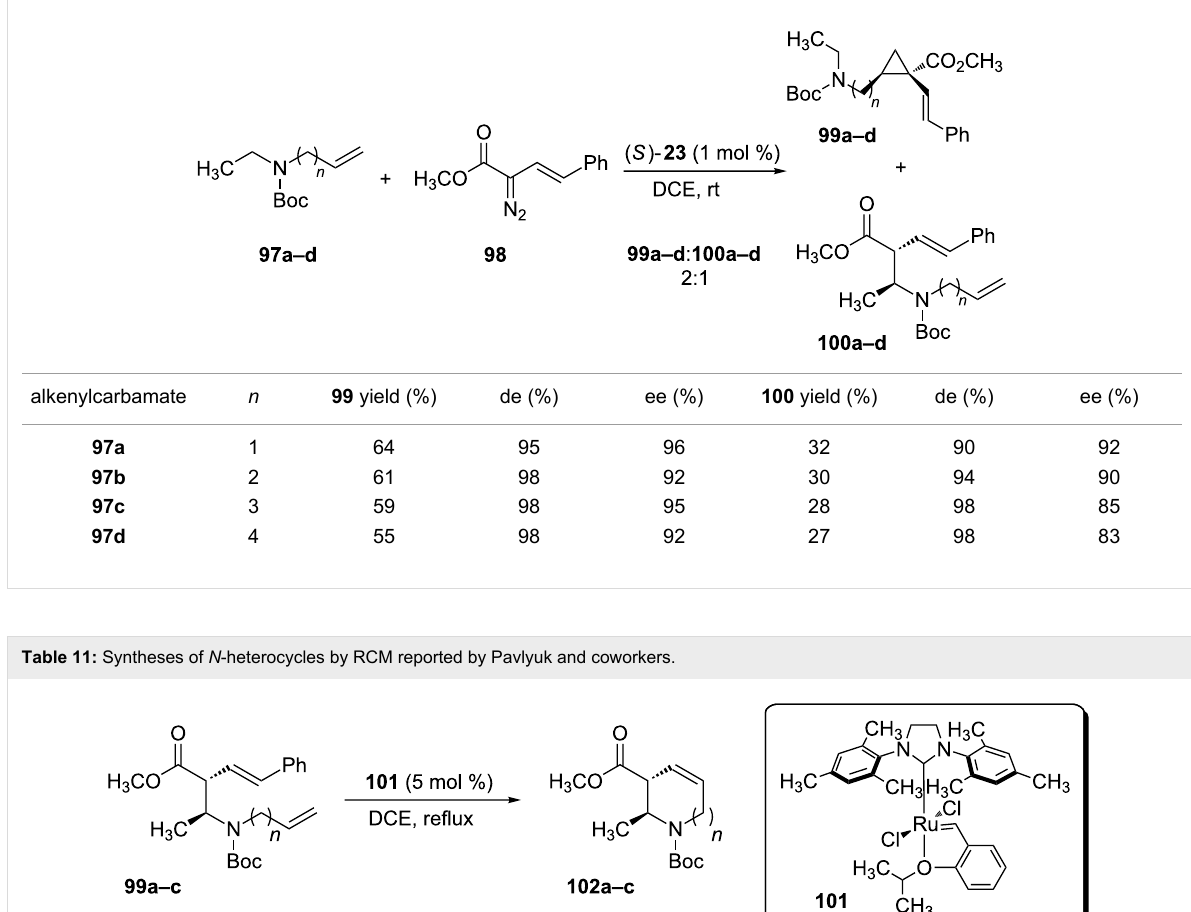
Table 10: Cyclopropanation/Insertion rhodium carbenoid reactions into C(sp 3 )–H reported by Pavlyuk and coworkers.